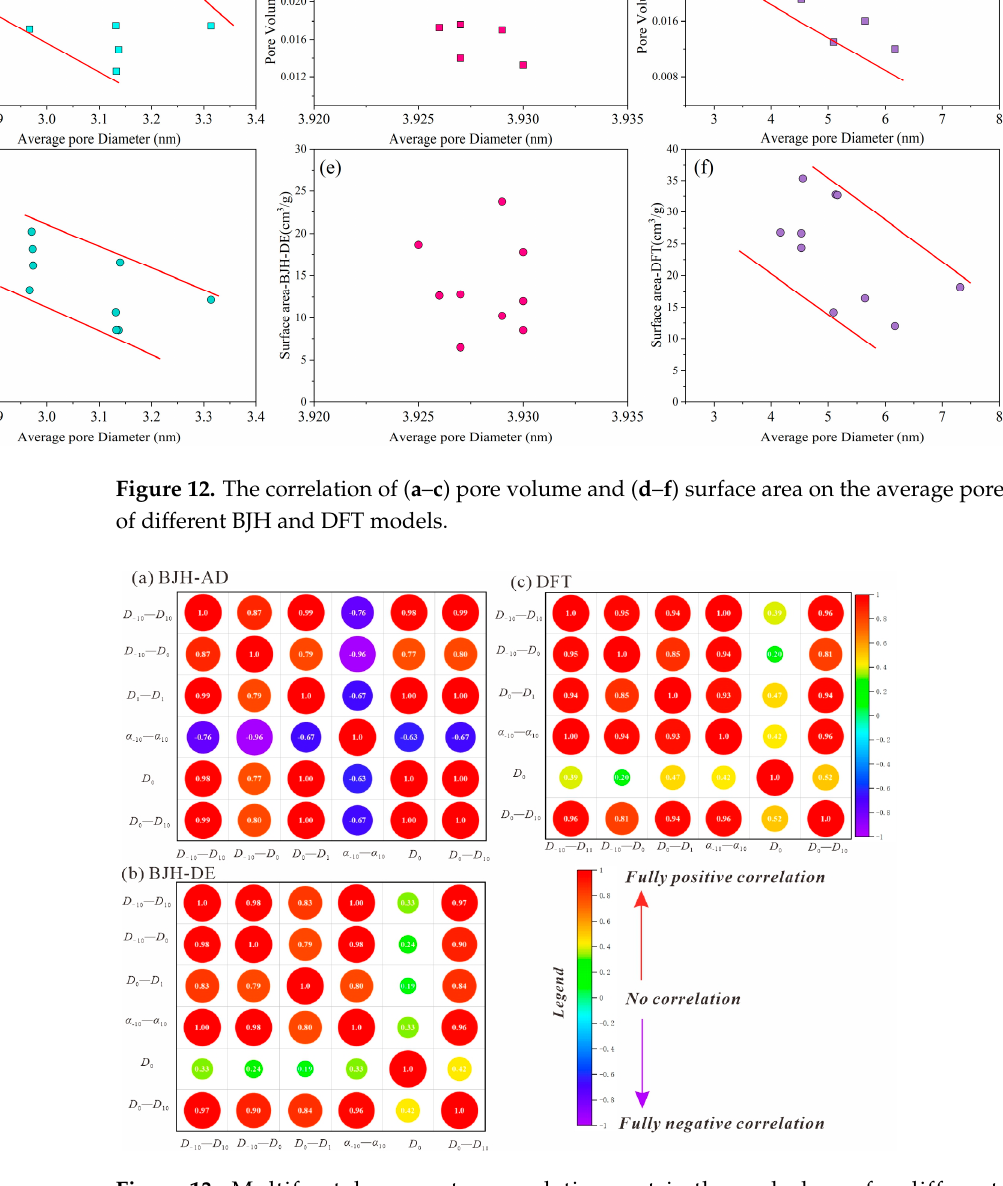
Figure 13. Multifractal parameter correlation matrix thermal planes for different nitrogen adsorption models.